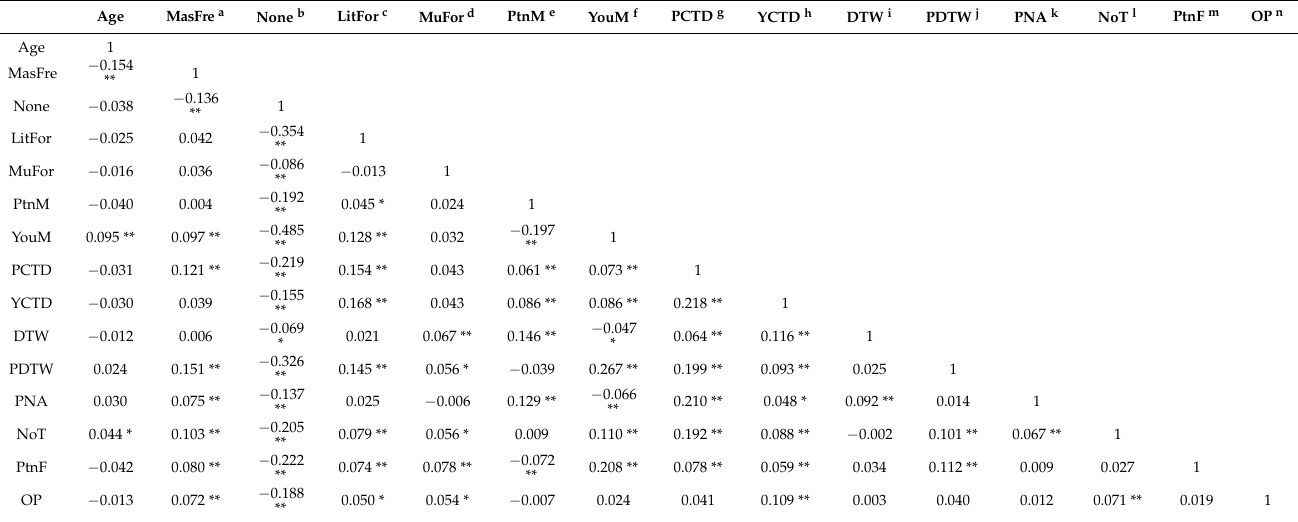
Table 5. Correlations between Age, Masturbation Frequency, and Relationship Problems for men who have a